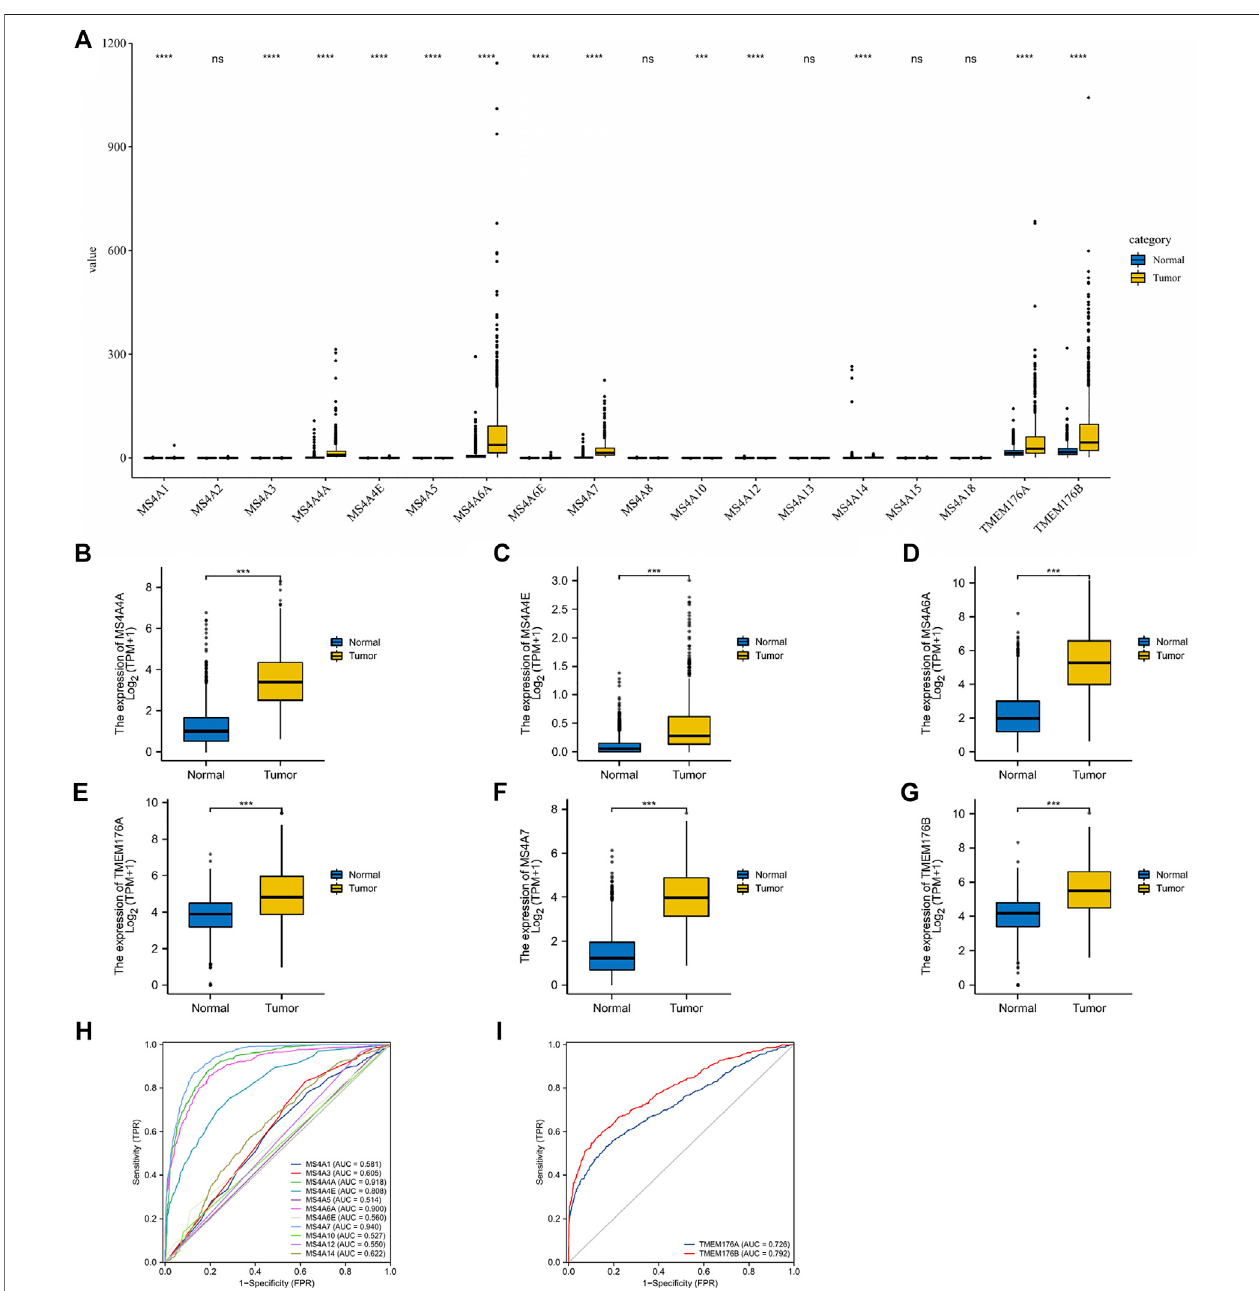
FIGURE 1 | Differential expression of MS4As in glioma. (A – G) MS4A mRNA expression level in glioma in TCGA dataset. (H,I) Receiver operating characteristic (ROC) curve analysis and area under curve (AUC) statistics were used to evaluate the ability of MS4As to distinguish gliomas from normal tissues. p - value: 0 ≤ * < 0.05.